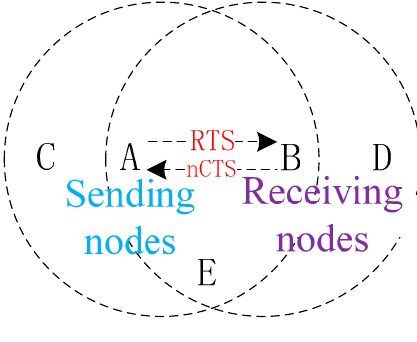
Figure 3. Interaction of nCTS.